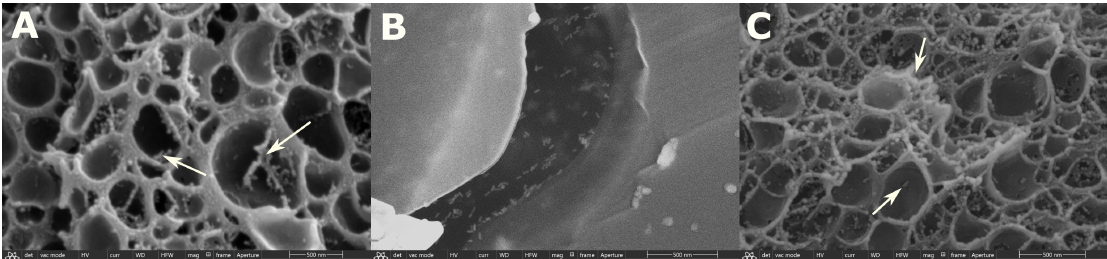
Figure 2. ( A ) SEM image of CPD AAM-BIS hydrogel with GNRs in SE mode; ( B ) air-dried GNR solution on carbon tape in SE mode for comparison with SEM images of GNP-hydrogels; ( C ) SEM image of HMDS-dried AAM-BIS hydrogel with GNP in BSE mode. The white arrows show the small-sized contrast features observed that could indicate GNR positions.